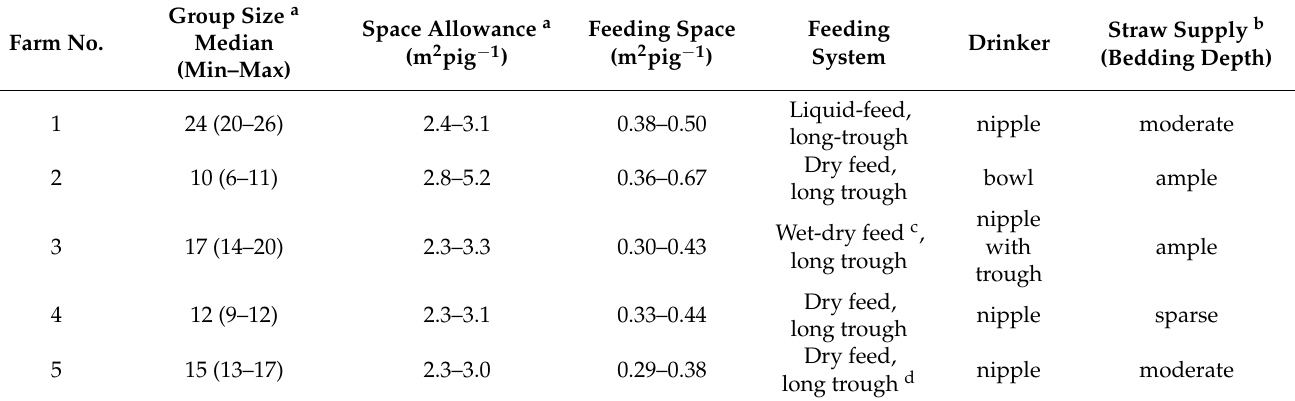
Table 1. Selected housing and management conditions of the five investigated farms.